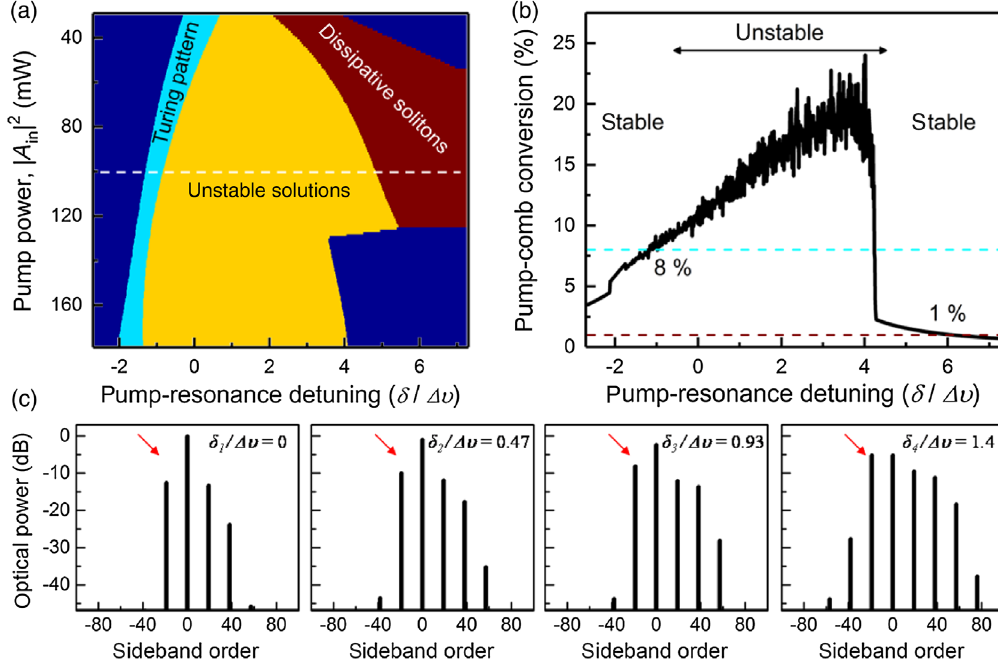
FIG. 1. (a) Stability diagram of the Turing pattern in the anomalous GVD regime. Light blue shows the region of the stable Turing pattern, yellow shows the region of breathers and spatiotemporal chaos, and red shows the region of the soliton and soliton molecules. (b) Pump-to-comb power-conversion efficiency along the white dashed line in (a), showing only 8% maximum power conversions to the Turing pattern before destabilization and transition to chaos happens. (c) Simulation of the Turing roll in the normal dispersion microresonator ( 1300 fs 2 ), where the Turing roll is excited by local mode hybridization. The red arrow points to the mode where local dispersion disruption is introduced in the Lugiato-Lefever model. It shows an apparent asymmetry and can be tuned further into resonance without triggering the subcomb growth and the associated Turing pattern destabilization, expanding the stability zone and opening the route to harness Turing pattern ’ s high coherence and exceptional robustness at high optical powers. Note that the pump- resonance detuning used in the simulation is referenced to the cold cavity resonance